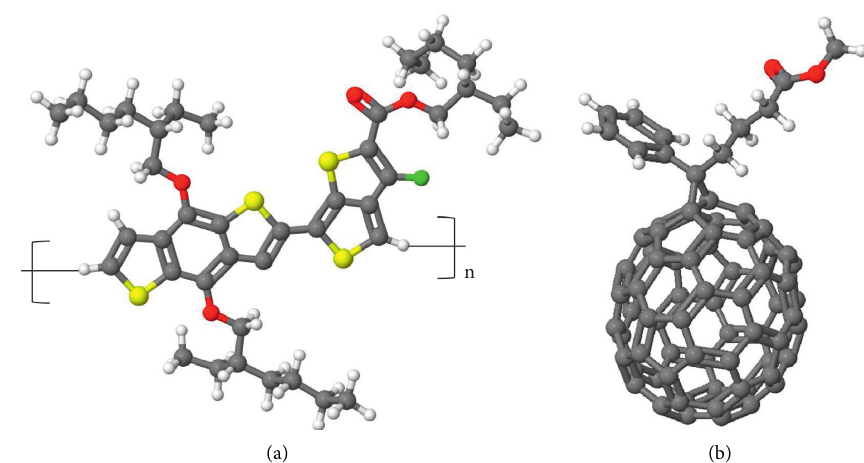
Figure 2: Molecular structure of PTB7 (a) and PC70BM (b) (colors: white represents hydrogen, red represents oxygen, yellow represents sulfur, green represents fluorine, and dark grey represents